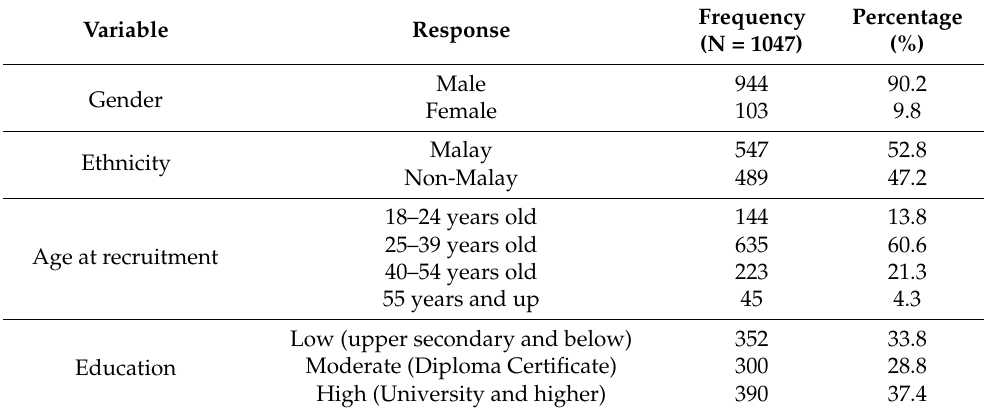
Table 1. Characteristics of the sample of Malaysian smokers (unweighted).